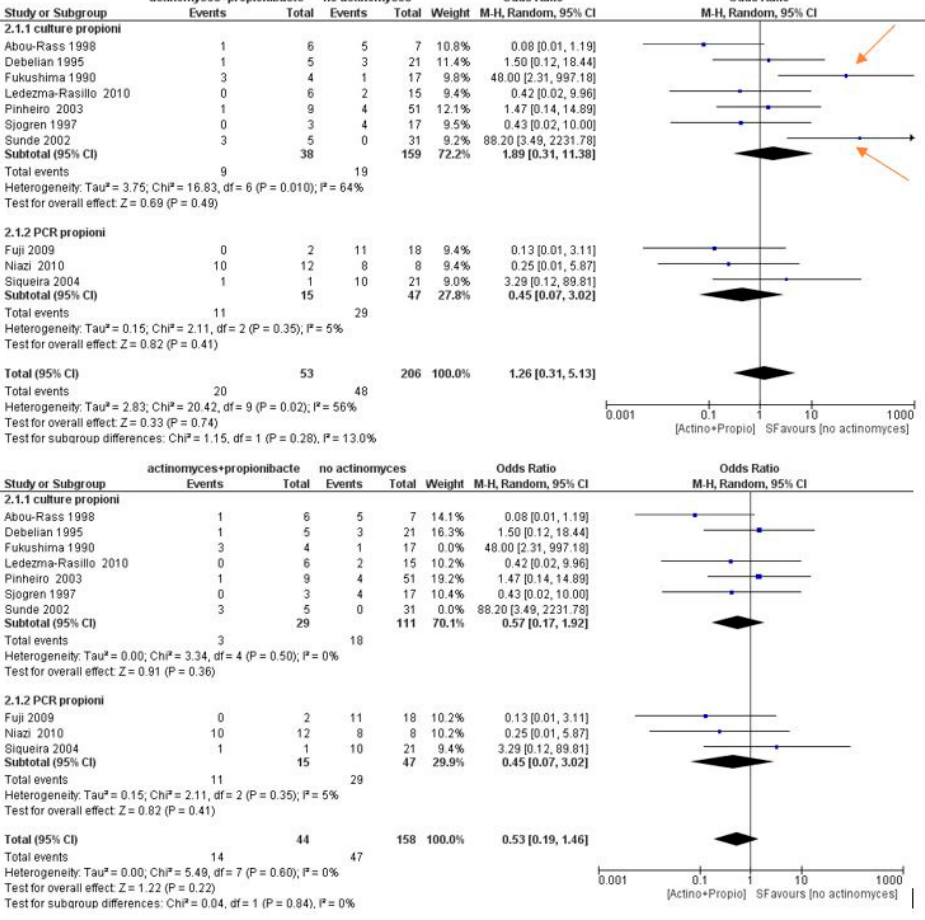
Figure 9. Meta-regression plot; it can be seen that the log odds ratio decreases when the risk of bias decreases, with a regression coefficient equal to − 0.140 per score of risk of bias points, and with a p value of 0.639.